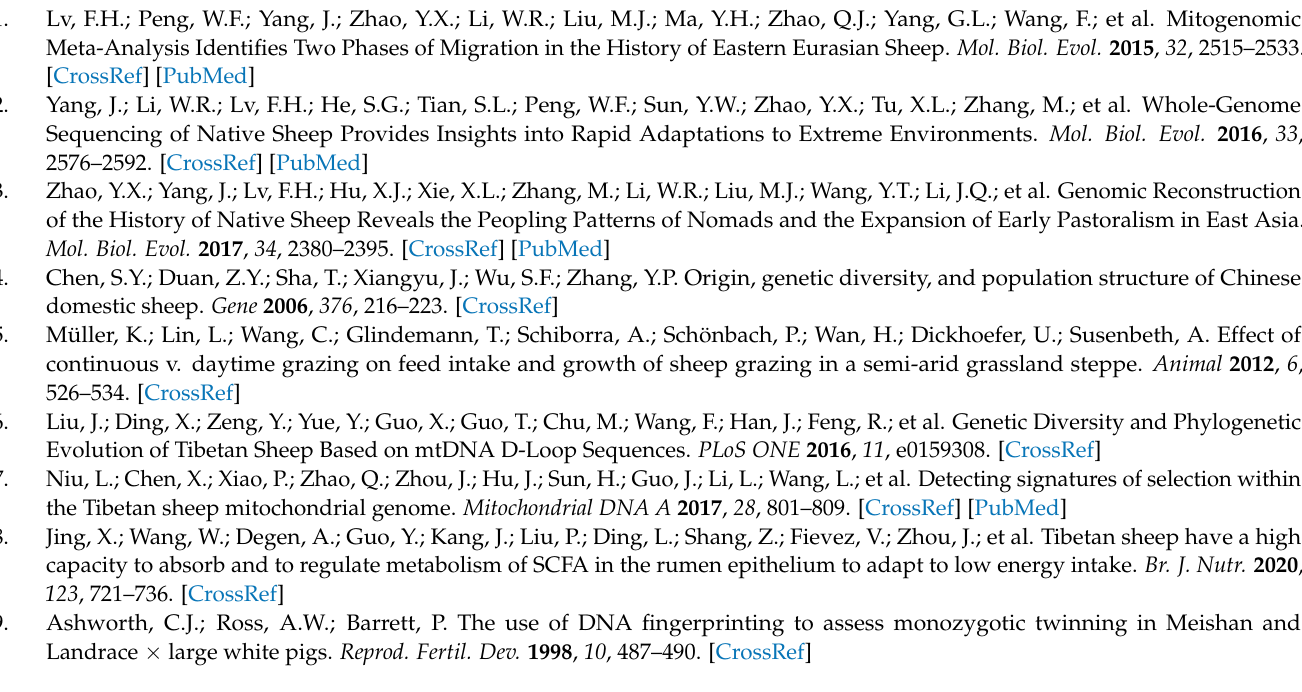
Table S2: Information on 20 breed-specific SNP genetic markers used to distinguish Zuogong sheep (ZG). Table S3: Information on 60 breed-specific SNP genetic markers used to distinguish Heizang sheep (HZ). Table S4: Information on 60 breed-specific SNP genetic markers used to distinguish Gongga sheep (GG). Table S5: Information on 30 breed-specific SNP genetic markers used to dis- tinguish Tao sheep (TS). Table S6: Information on 60 breed-specific SNP genetic markers used to distinguish Tibetan sheep in